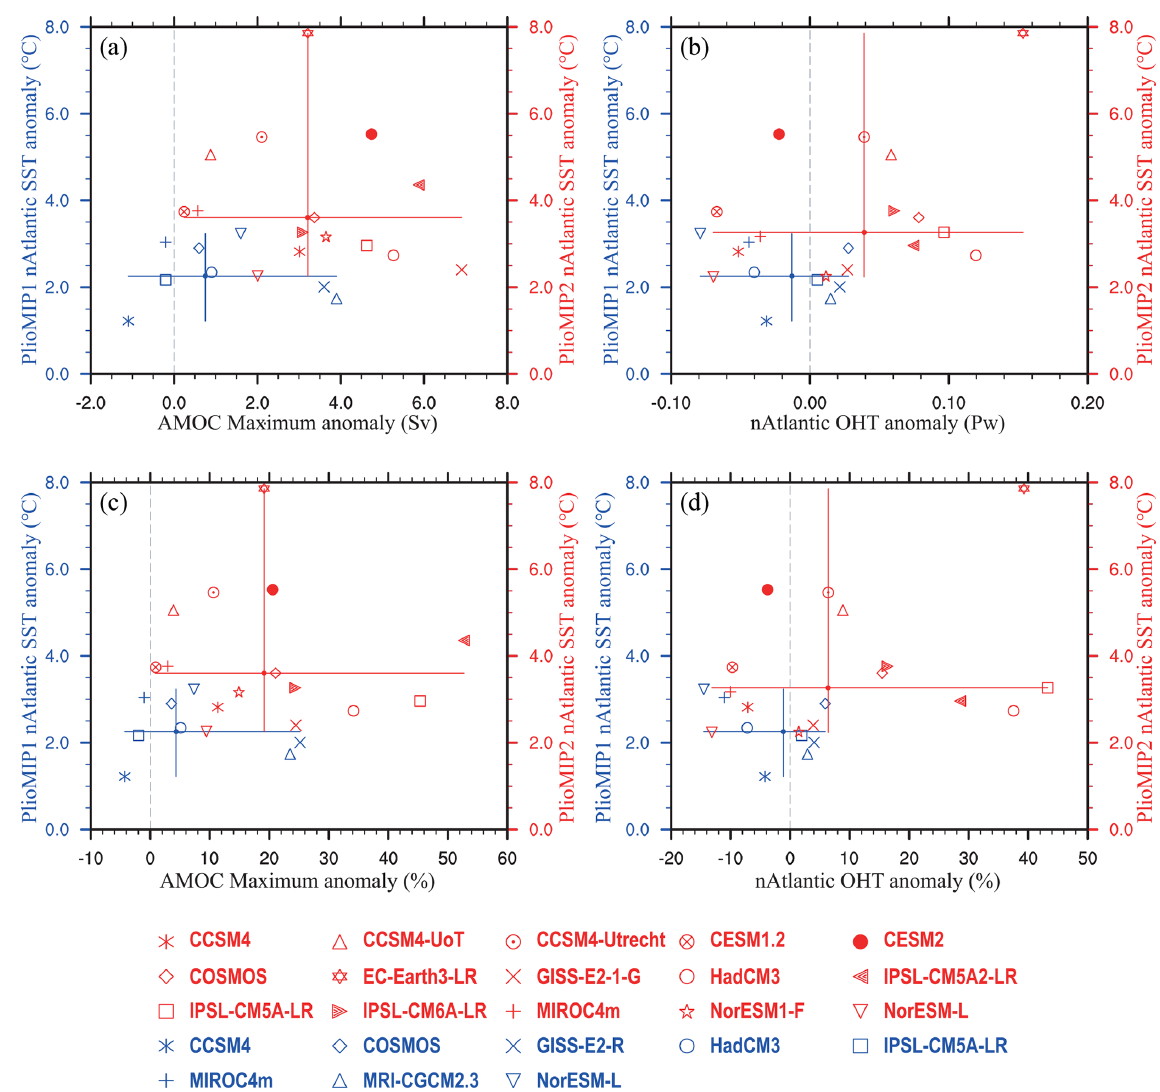
Figure 5. Simulated changes in the AMOC maximum and the North Atlantic (nAtlantic) OHT, and responses in the high-latitude North Atlantic SST. The North Atlantic OHT is the averaged value between 30 and 80 ◦ N. The high-latitude North Atlantic includes the Atlantic and Greenland–Iceland–Norwegian (GIN) seas between 30 and 80 ◦ N. Note that only the mean values of the AMOC maximum, the North Atlantic OHT and the SST for each model are used to calculate the anomalies, and significance tests are not